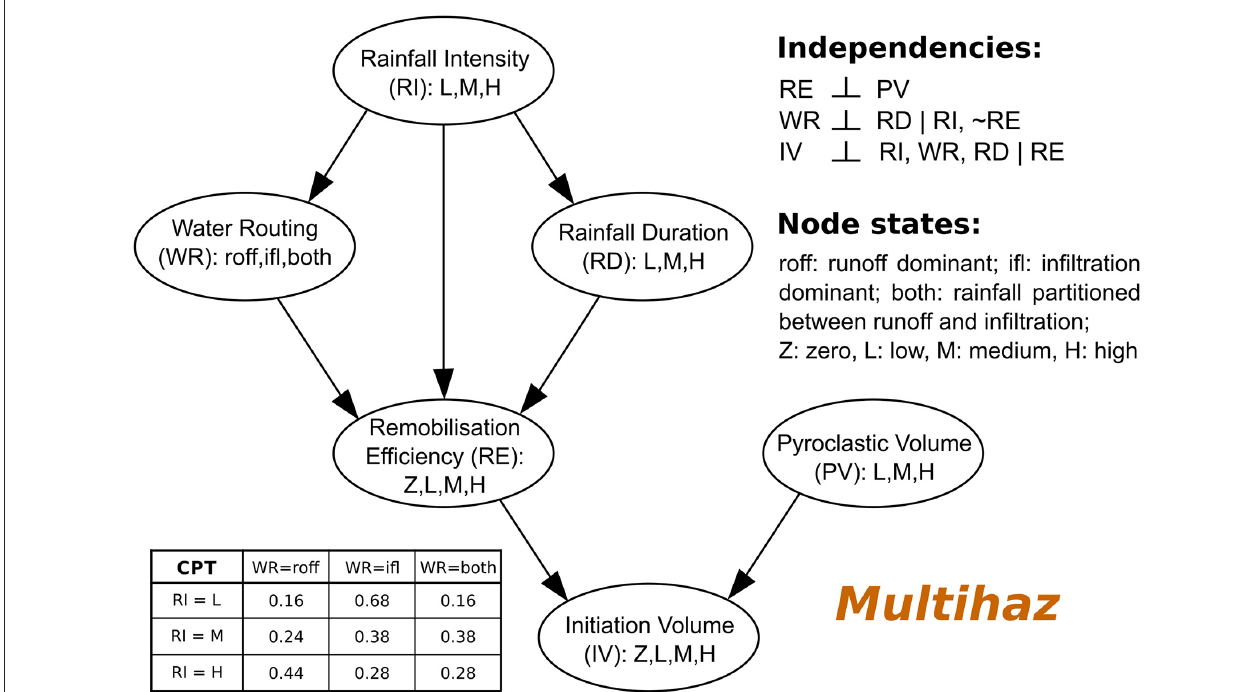
FIGURE 2 | The generalizable probabilistic model proposed in this study: Multihaz . Variables (or nodes) are displayed as ovals while conditional relationships (or arcs) are shown as arrows, with the parent nodes pointing to the child nodes. Abbreviations for the names of the nodes are given in brackets at each node and are used throughout the paper. The abbreviations for the states of each node as well as the independence relationships between nodes that the Multihaz structure implies are reported (“ ⊥ ” denotes independence between variables while “ ∼ RE” denotes that the RE is not observed). On the bottom left, the Conditional Probability Table (CPT) for the WR node is displayed (see text for more